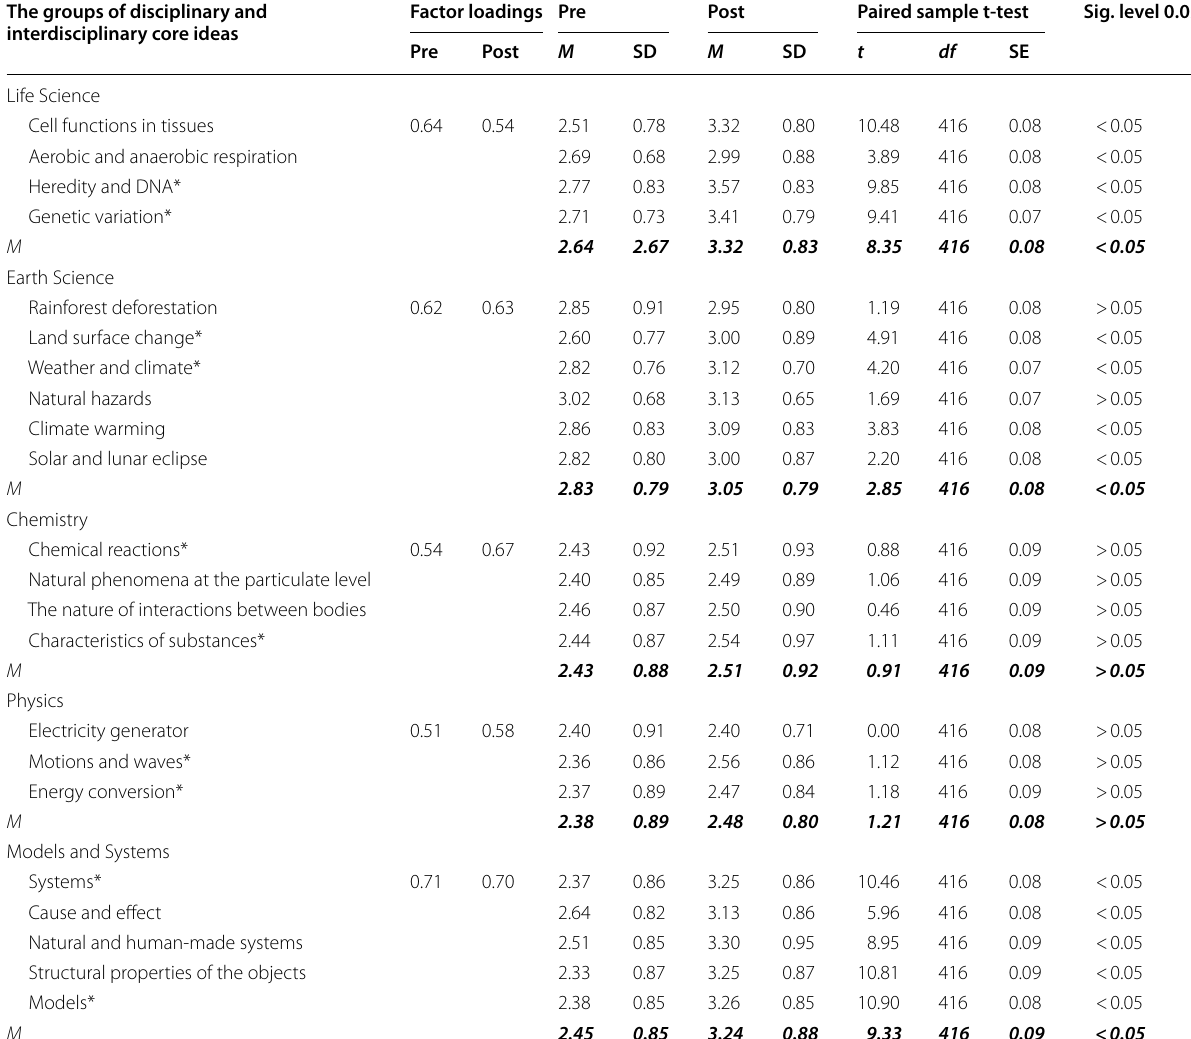
Table 6 A pre- and post-questionnaire results comparison using CFA on students’ perceived self-efficacy towards disciplinary and interdisciplinary core ideas, for the experimental group ( N =